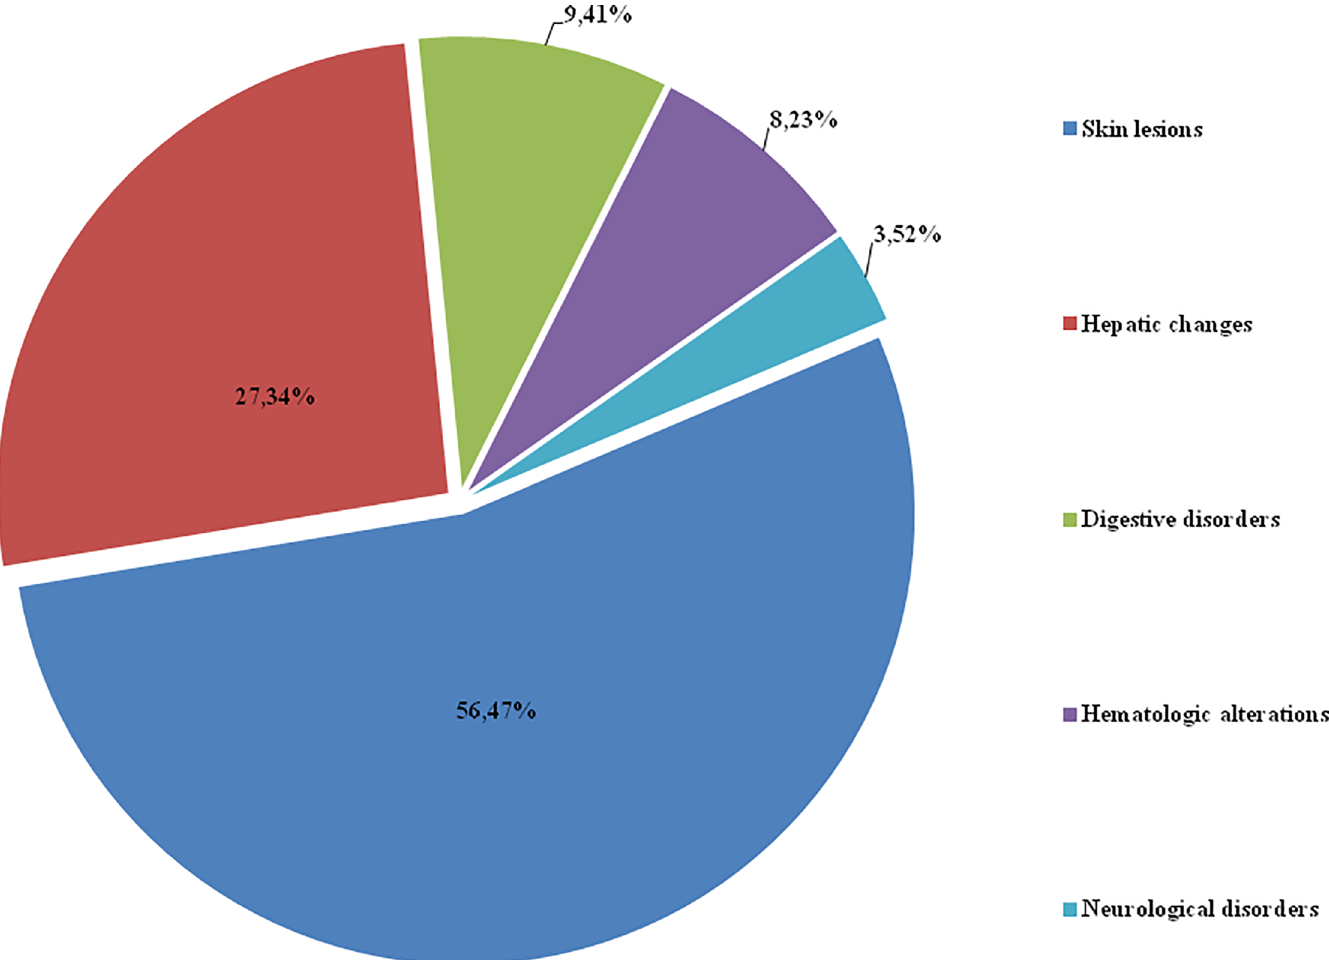
Fig 2. The adverse events. Frequency of adverse events to